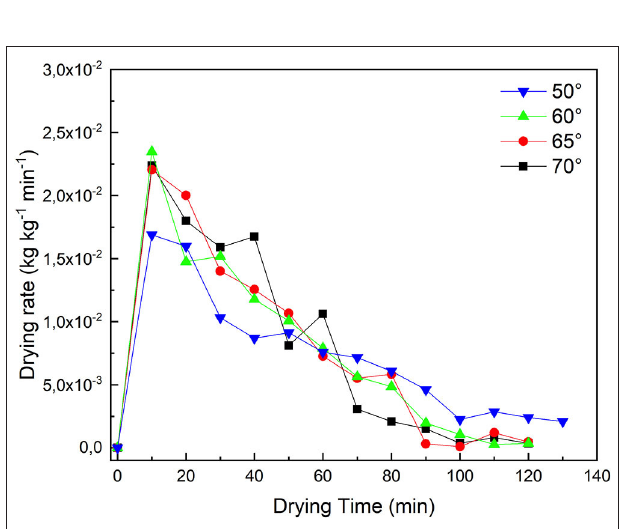
FIGURE 2 | Drying rate of pumpkins at 50, 60, 65, and 70 ◦